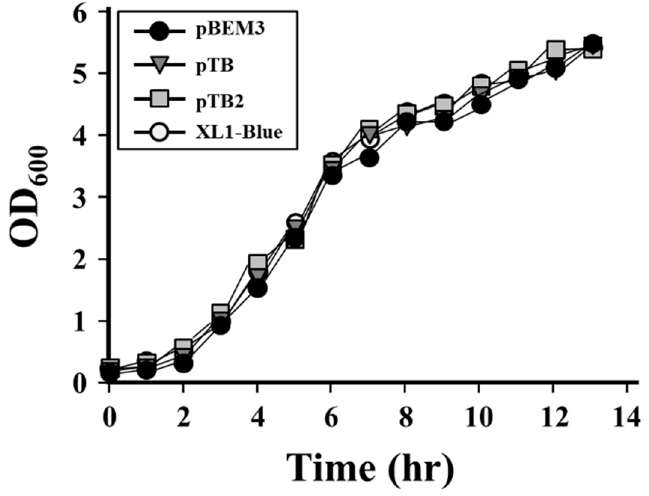
Figure 3. Comparison of growth curve of recombinant cells harboring the new expression vectors. The recombinant cell harboring pTB2 expression vector was used as a control.